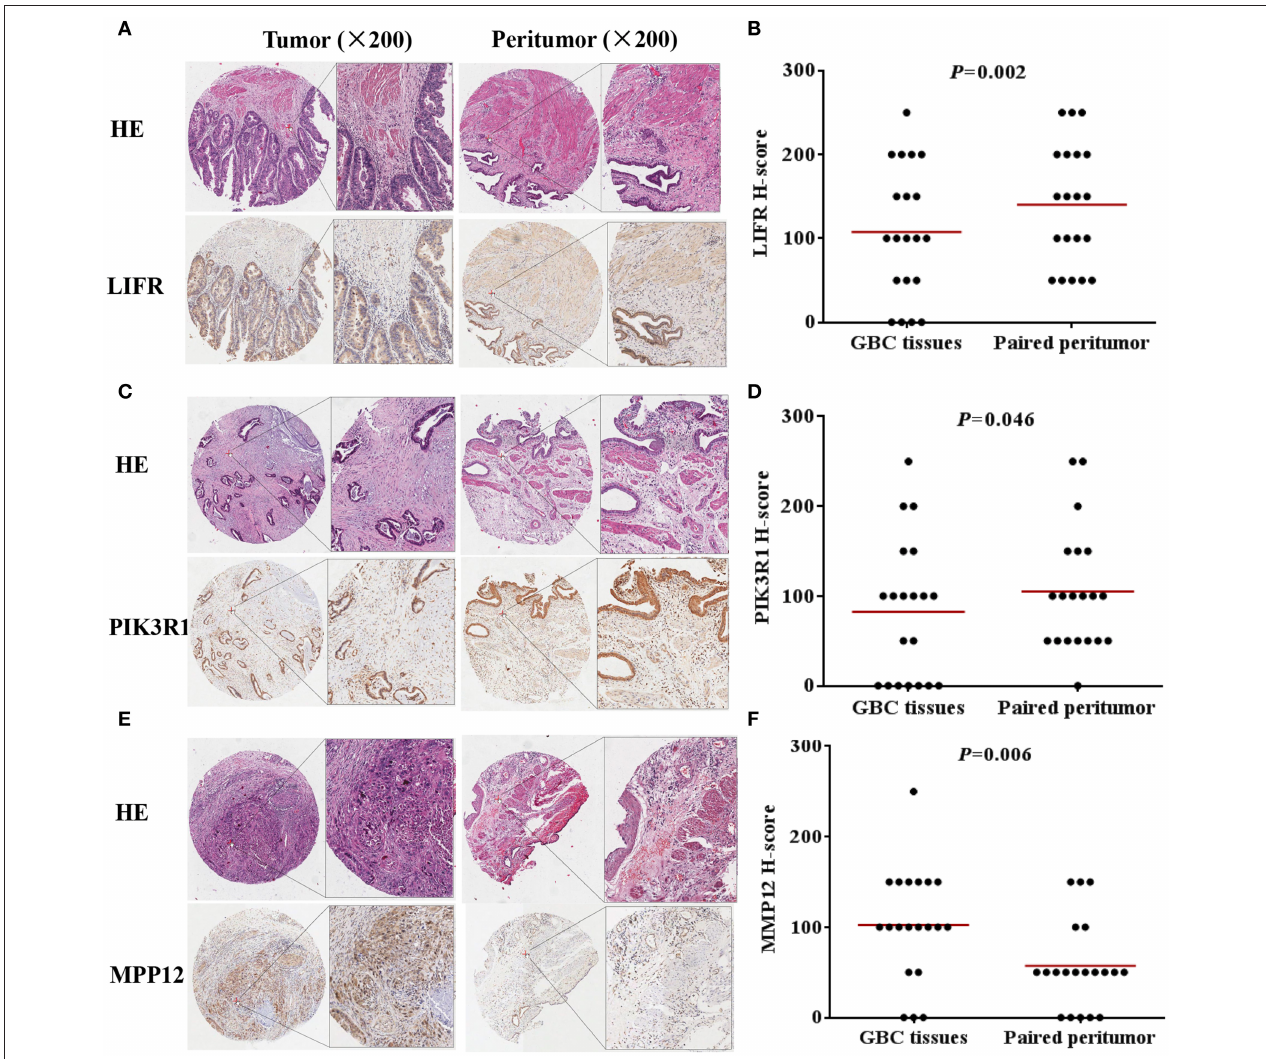
FIGURE 3 | LIFR , PIK3R1, and MMP12 expression in gallbladder cancer tissue. Immunostaining of LIFR (A) expression in a representative tumor tissue and matched non-tumor tissue; original magnification × 200. (C,E) are representative images of PIK3R1 and MMP12 , respectively. The differential protein expression of LIFR (B) , PIK3R1 (D) , and MMP12 (F) are shown in GBC tissues and matched non-tumor tissues of 20 patients as indicated. The median extent of expression of each protein is indicated by the horizontal line in the scatterplot